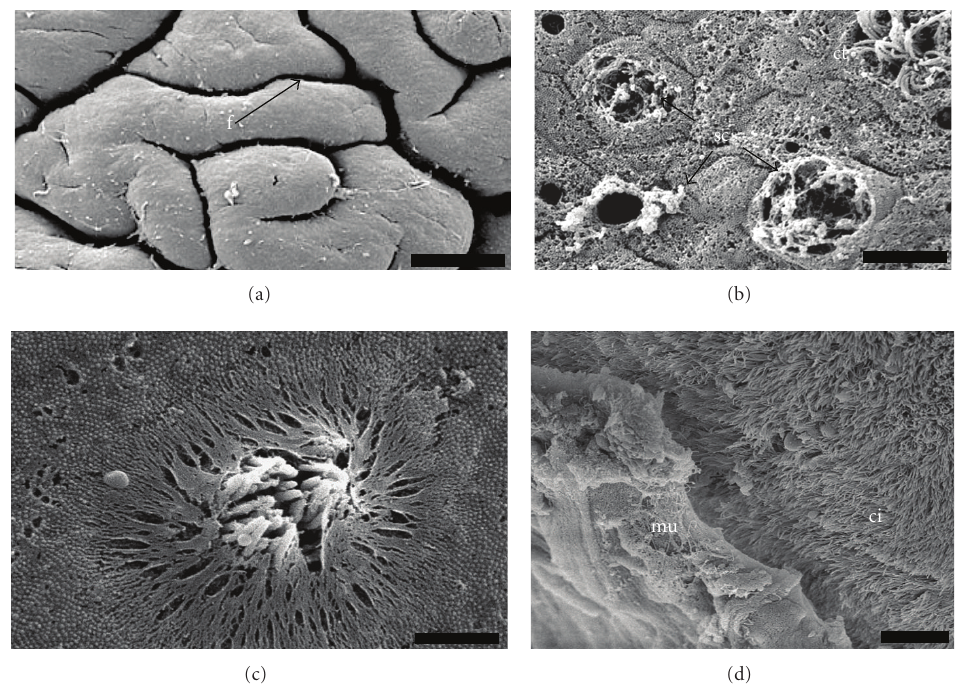
Figure 2: Scanning electron micrograph. (a) General view of the side foot showing the folds (f) in the external surface. Bar: 200 µ m. (b) Detail of the external surface of the side epithelium, ciliary tuft (ct), and opening of the secretory cells (sc). Bar: 5 µ m. (c) Ciliary tuft in the side foot. Bar: 2 µ m. (d) General view of the sole foot showing the long field of cilia (ci) and the mucus layer (mu). Bar: 10 µ